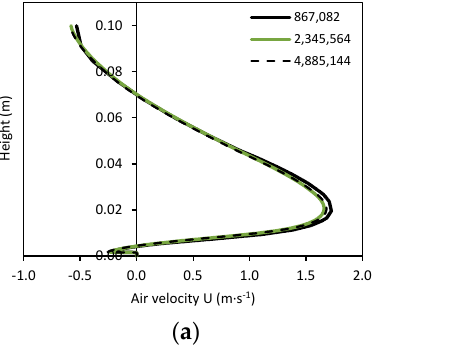
Figure 7. A grid independency study with three density grids. ( a ) vertical profile, and ( b ) horizontal profile inside middle of the NVD barn with SM opening conditions.